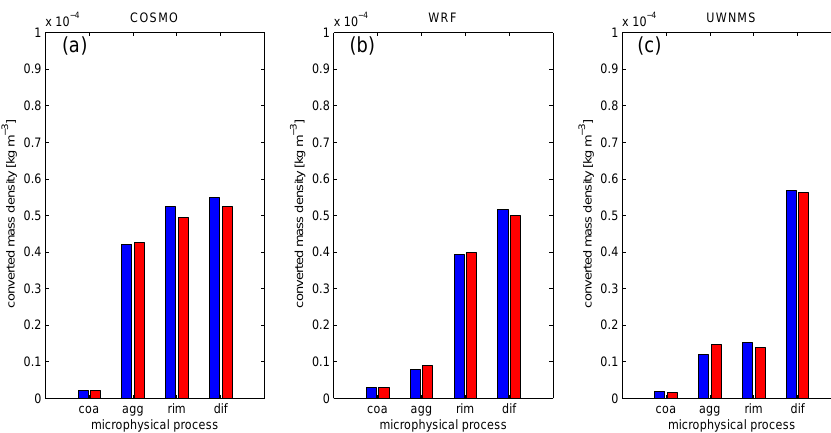
Fig. 19. Same as Fig. 10 but for the simulations SIM 3 CC (blue) and SIM 3 PC